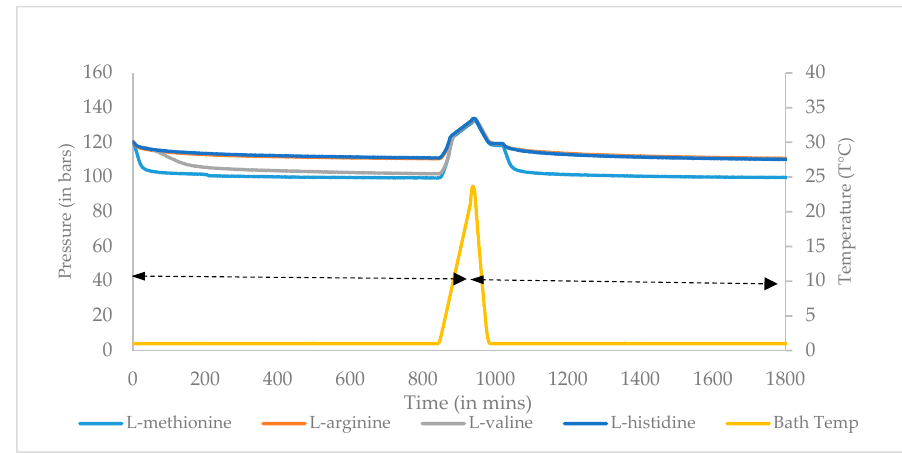
Figure 3. Flue gas (20 mole% CO2) hydrate formation in the presence of amino acids at 1 °C: P-T variation during isothermal experiments for selected amino acid during flue gas hydrate formation.